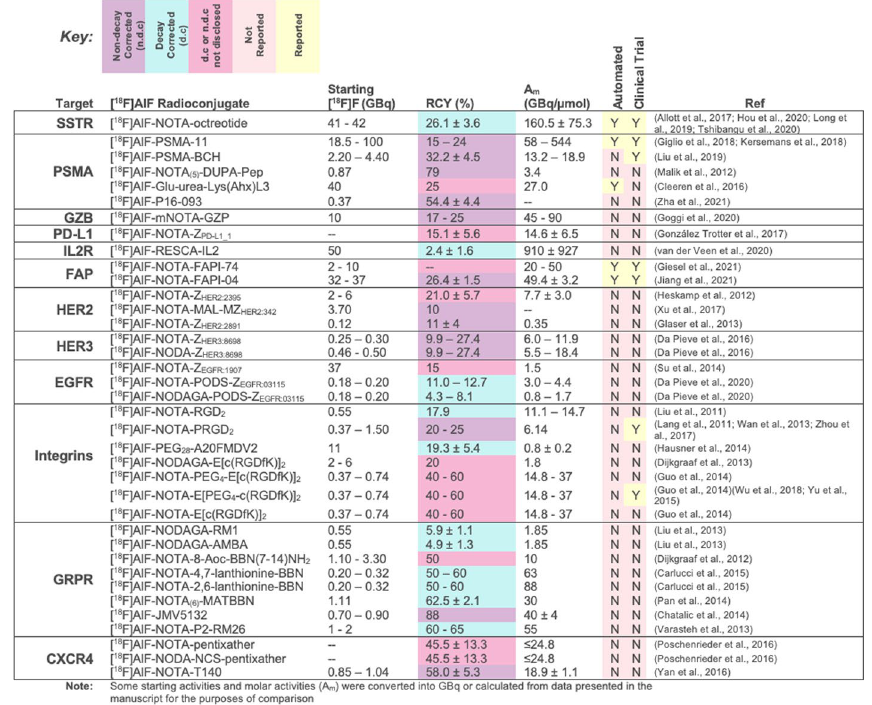
Table 2 Prominent examples of [ 18 F]AlF radioconjugates discussed in this review